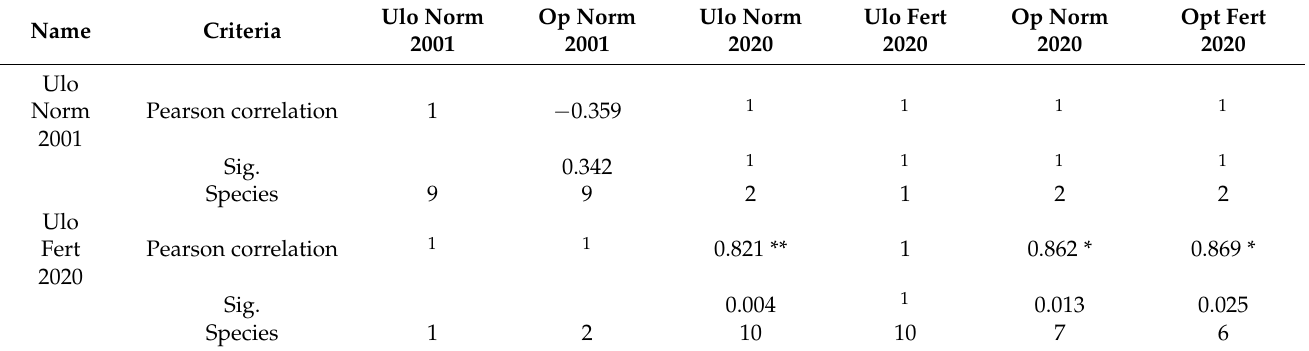
Table 6. Correlation and significance (2-tailed) of east test plots, 10-cm media, based on the number of similar plant species, in a comparison between 2001 and 2020. Significance here means: the fertilizer equalize differences between the different vegetation stands also on the east plots.